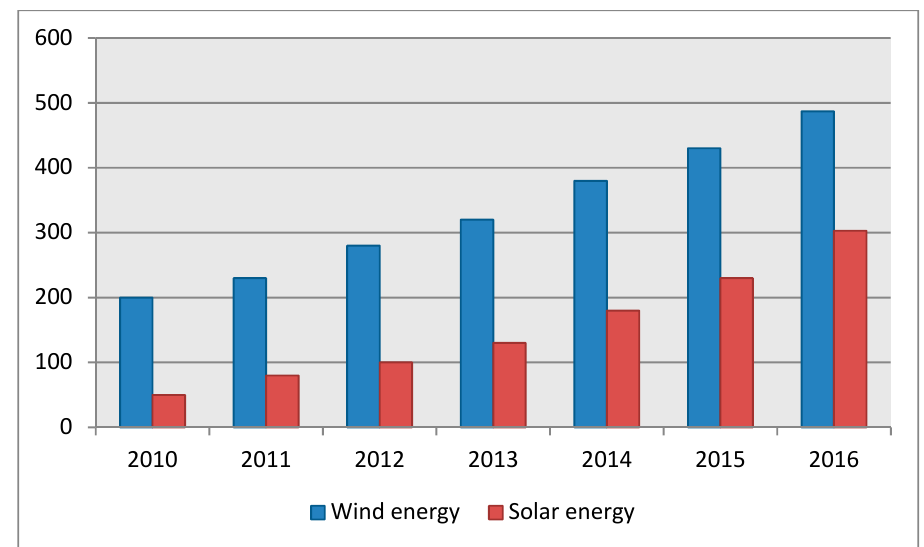
Figure 2. World wind and solar production capacity, GW.